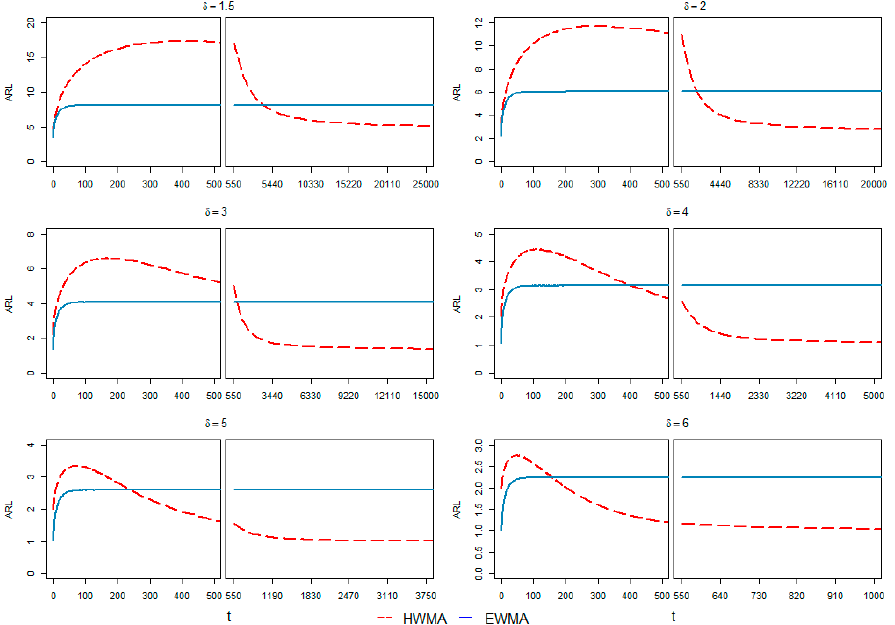
Figure 3. CED curves for the HWMA and EWMA charts under moderate to large shifts at 𝜆 = 0.03 with respect to time points (𝑡) .